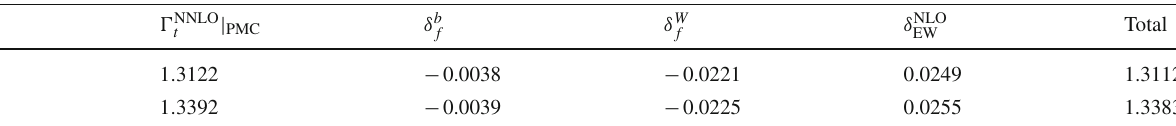
(in unit GeV) for m t = 172 . 5 and 173 . 5 GeV. These corrections δ b , the and δ NLO are taken from Ref. [19] f EW EW